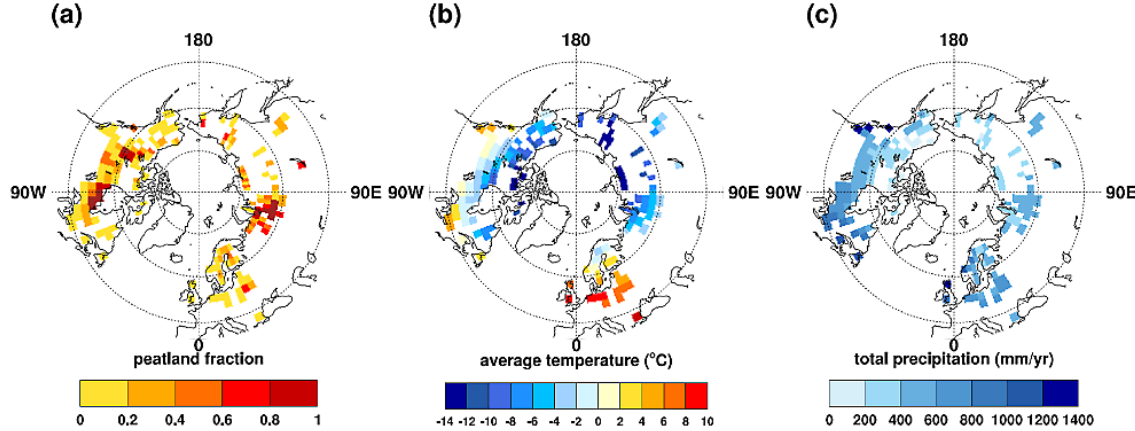
Fig. 4. Distribution and grid cell fraction of peatlands based on (Tarnocai et al., 2009) for present conditions (a) ; Northern Hemisphere climate patterns averaged over 1961–1990 CRU data (New et al., 1999; Mitchell and Jones, 2005) for temperature (b) and precipitation (c) , at the peatland grid